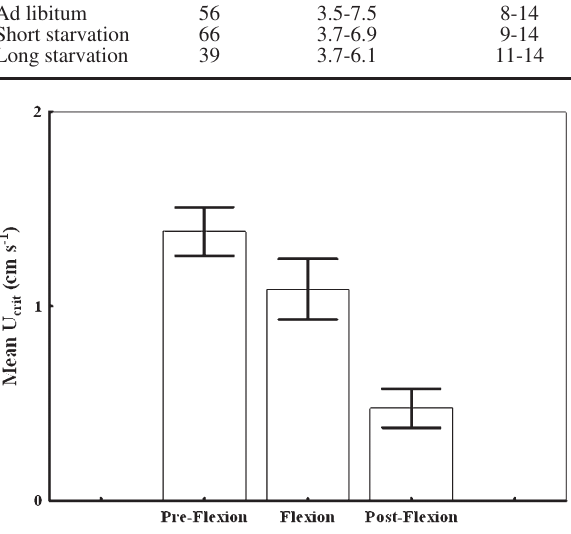
Fig . 3. – Mean U (± SE) of S. senegalensis larvae in pre-flexion, crit flexion and post-flexion stages.